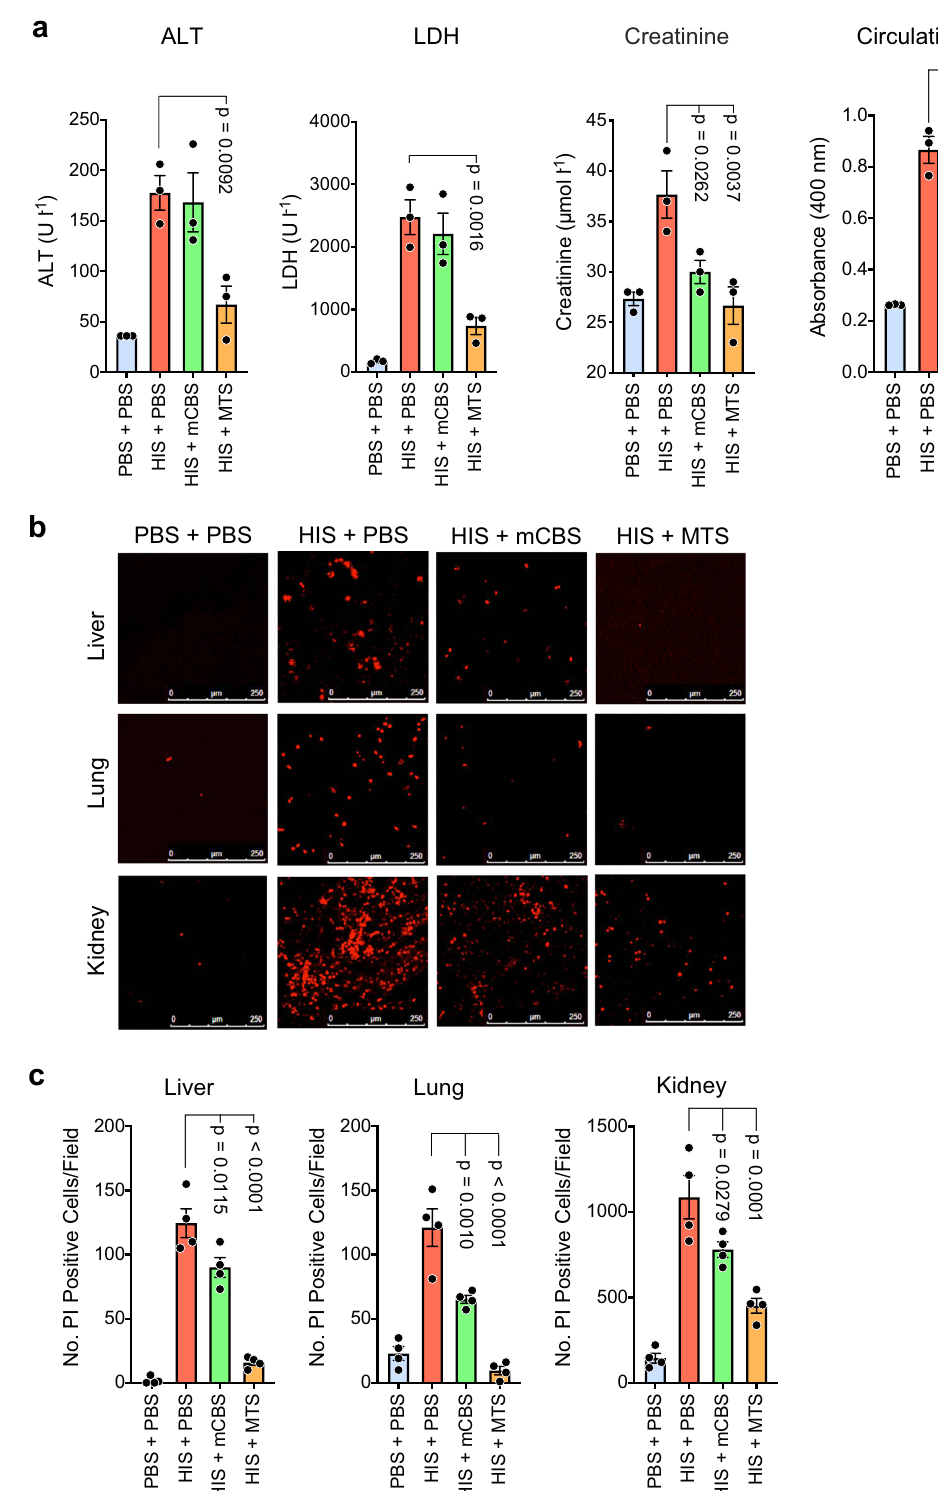
Fig. 5 In vivo SPAs inhibit ongoing tissue injury induced by histones. a Mice ( n = 3/group) were initially injected i.v. with histones (50 mg kg − 1 ), and 2 h later, when ongoing tissue injury was evident, they were injected i.p. with mCBS or MTS (100 mg kg − 1 ), with plasma collected 30 min later and analyzed for content of ALT, LDH, creatinine, and Hb. b Mice were treated as in a but 5 min before sacri fi ce they were injected i.p. with propidium iodide (PI), and liver, lung, and kidneys were collected and examined by confocal fl uorescence microscopy for dead ( fl uorescent red) cells, with representative fi elds from the various treatments being shown; scale bar 250 µ m. c Same animals were quanti fi ed for the number of dead (PI + ) cells per fi eld in the different treatment groups ( n = 4 mice per group), with at least four fi elds quanti fi ed/organ. Data are presented as mean ± s.e.m. and analyzed by one-way ANOVA with Dunnett ’ s correction for multiple comparisons. Source data are provided as a Source Data